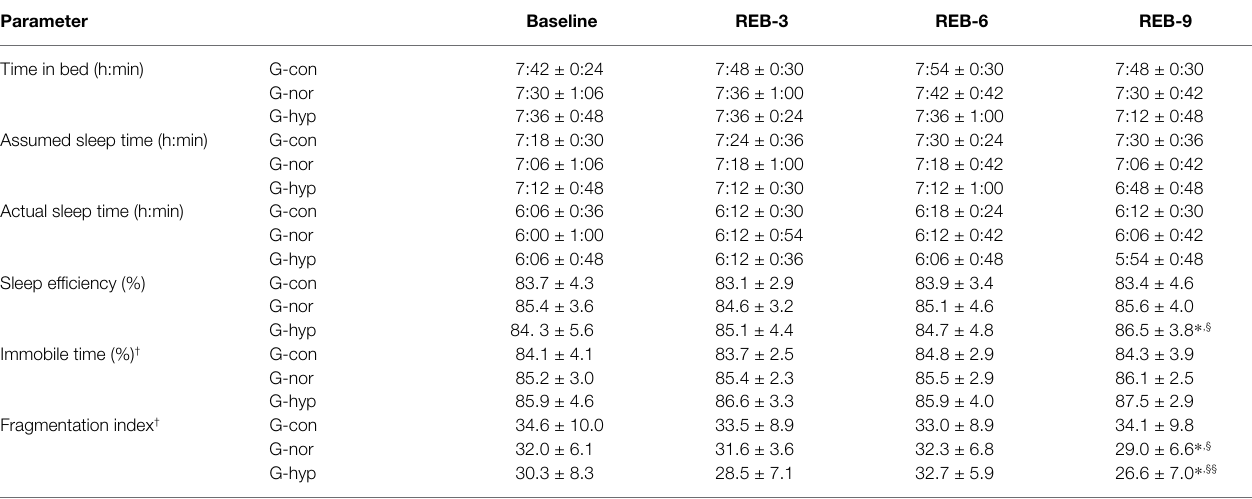
TABLE 3 | Sleep actigraphy data at selected time points throughout the Rebalance© Program (mean ± SD). Parameter Baseline Time in bed